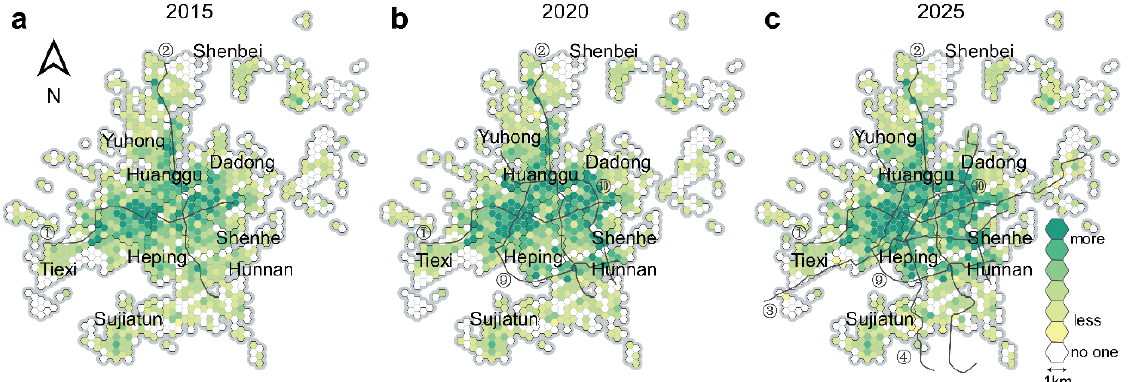
Figure 6. Spatial quality accessibility to healthcare services at different stages of subway system development: ( a ) accessibility in 2015; ( b ) accessibility in 2020; ( c ) accessibility in 2025.